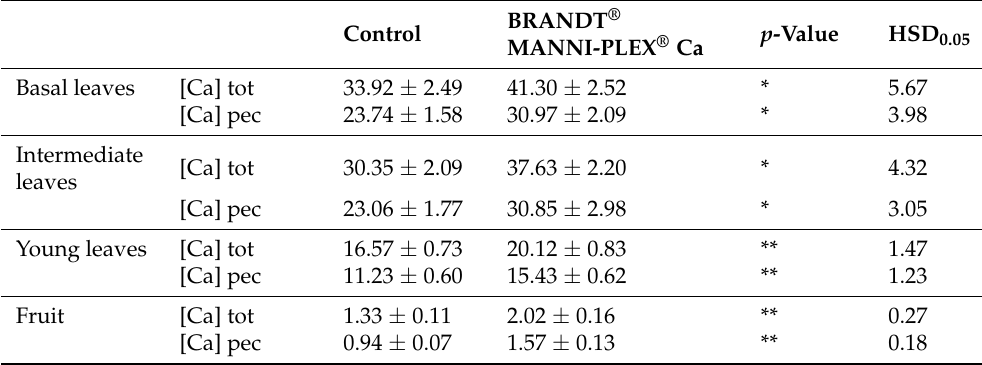
Table 2. Effect of BRANDT ® MANNI-PLEX ® Ca application on the concentration of total Ca and Ca bound to pectins (mg g − 1 DW) in pepper